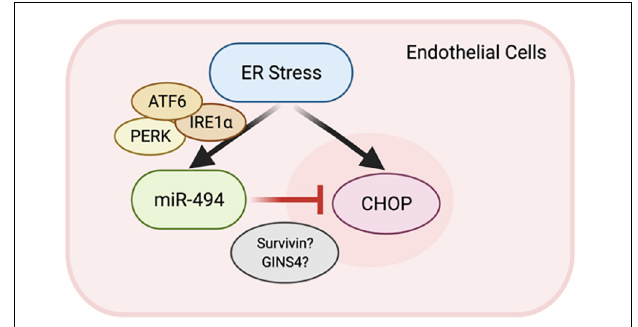
FIGURE 4 | A feedback loop between miR-494 and ER stress. Schematic showing the relationship where ER stress induction of miR-494 inhibits DDIT3 and functions to dampen ER stress via modulation of target genes including BIRC5 and GINS4